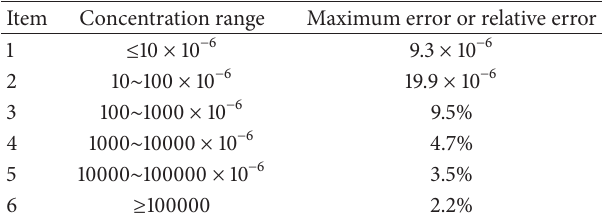
Table 4: Maximum testing error of relative